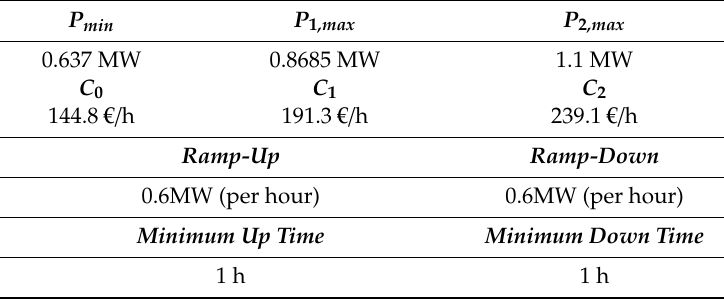
Table 1. Characteristics of the conventional production units in Kythnos. P